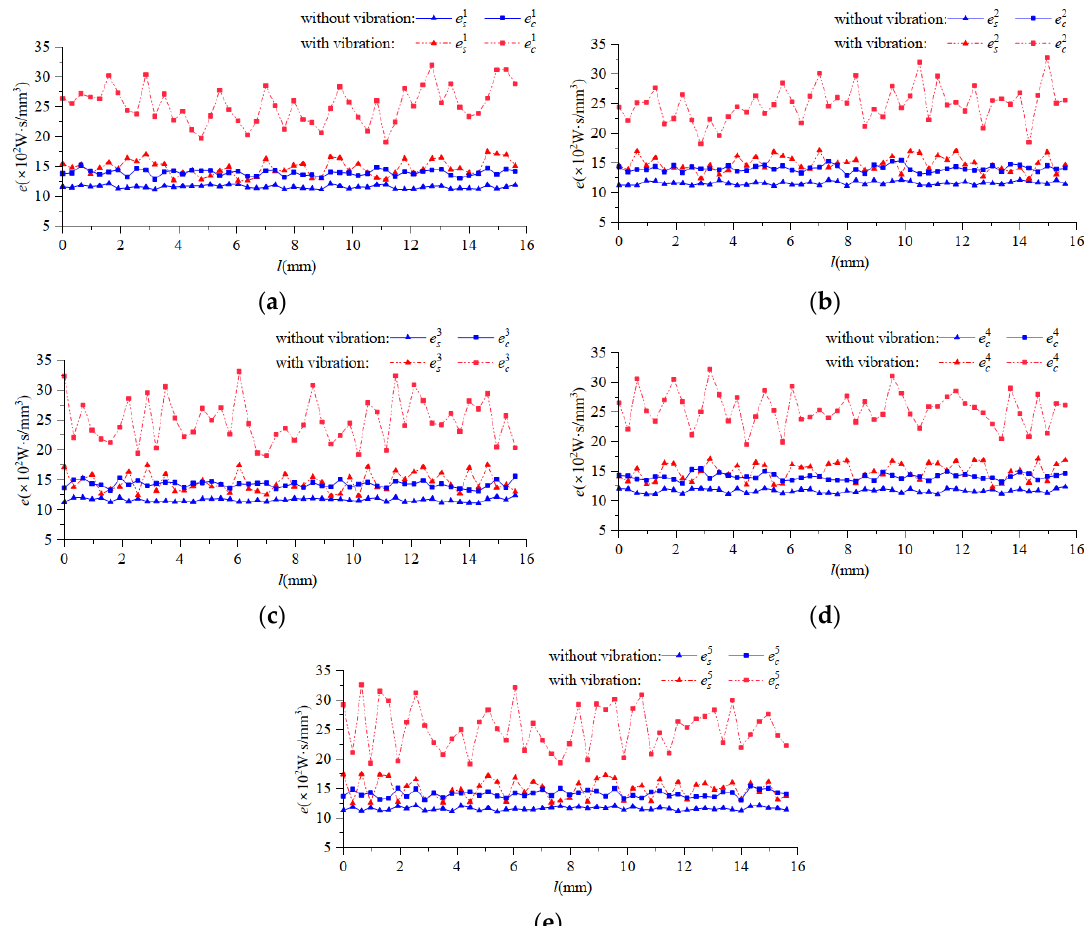
Figure 13. The distribution of instantaneous specific cutting energy along cutting edge. ( a ) Tooth 1; ( b ) Tooth 2; ( c )Tooth 3; ( b ) Tooth 4; ( e ) Tooth 5.